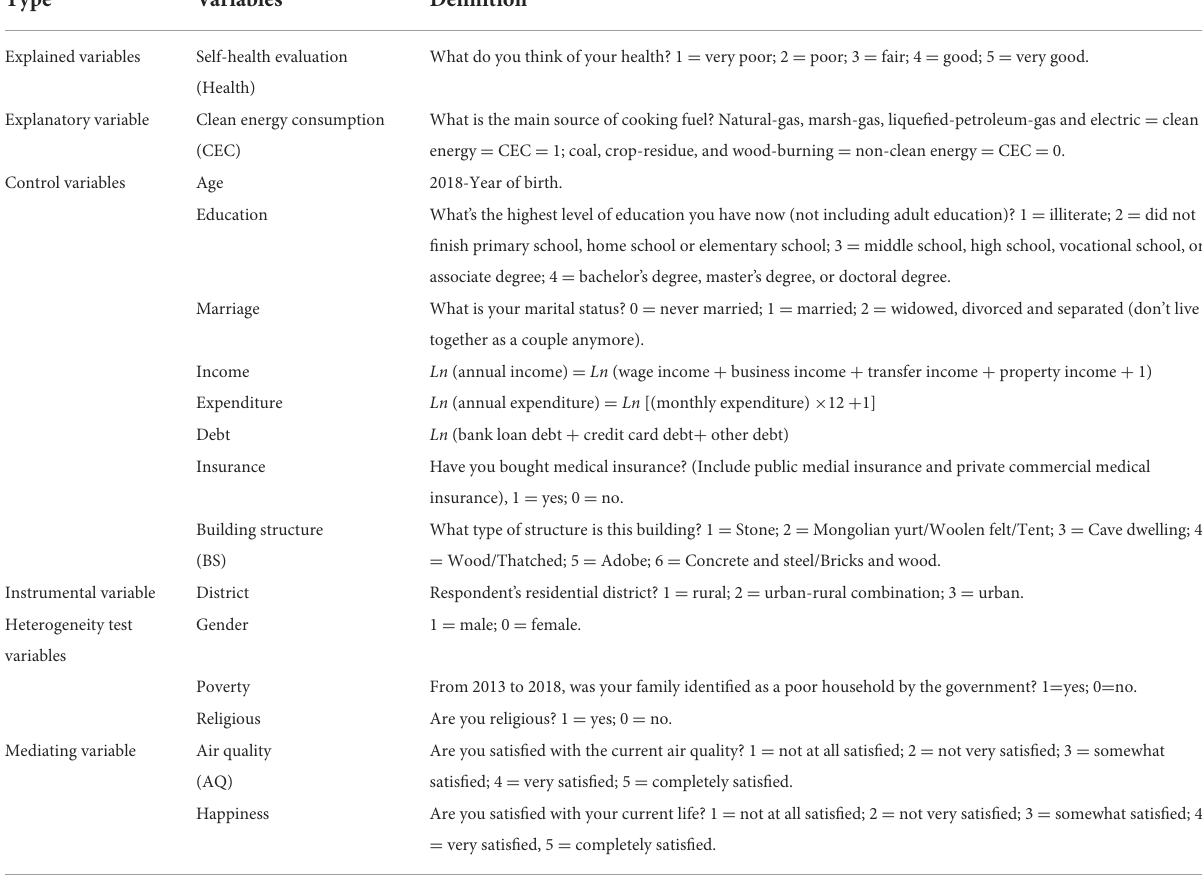
TABLE 1 Variables selection and